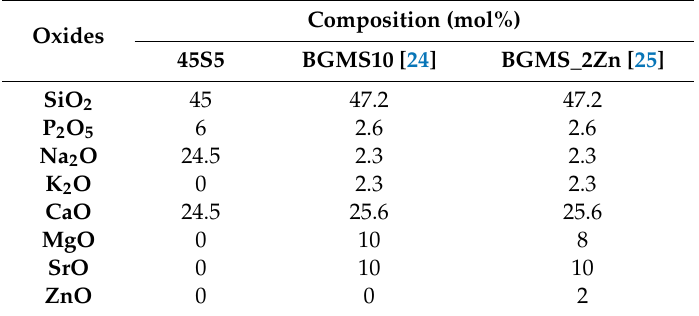
Table 1. Composition of 45S5 and the produced bioactive glasses.